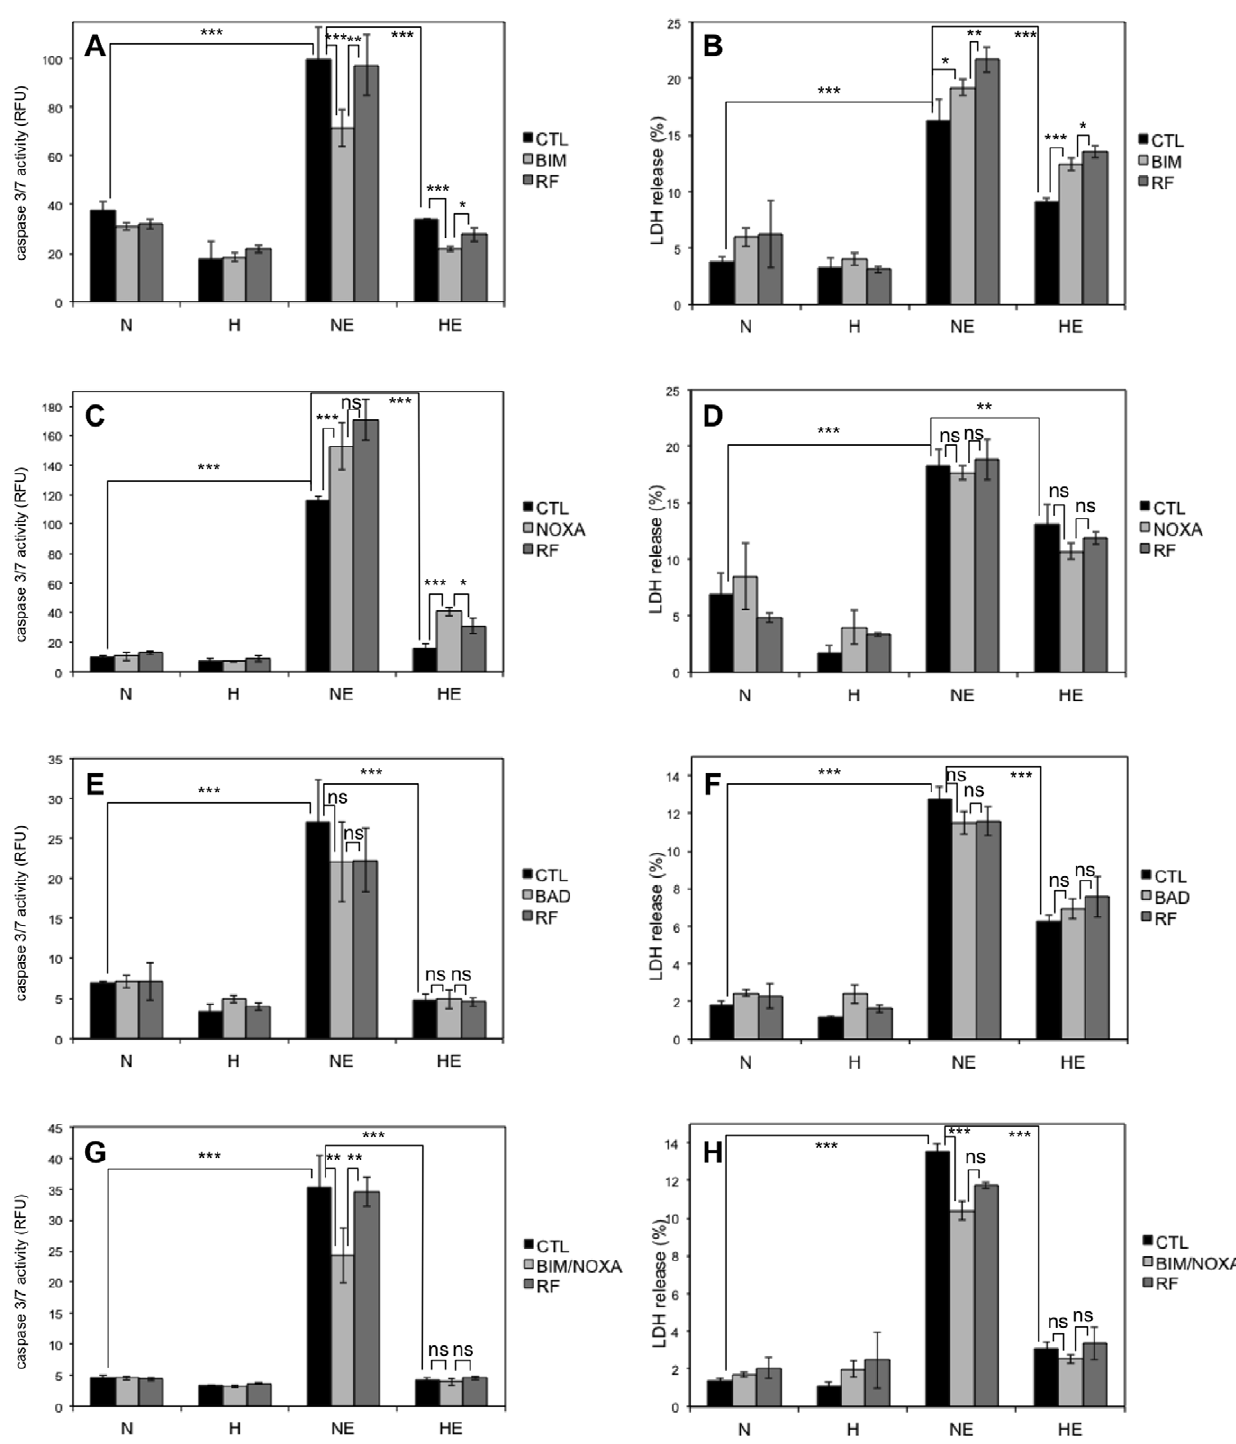
Figure 7. Effect of BH3-only proteins silencing on the etoposide-induced cell death . HepG2 cells were transfected with 50 nM BIM (A, B), NOXA (C, D) or BAD (E, F) siRNAs, or 25 nM BIM combined with 25 nM NOXA (G, H), or 50 nM RISC-free (RF) control siRNA or left untransfected (CTL) for 24 hours. 6 hours later (or 30 hours later for A and B), cells were incubated under normoxia (N, 21% O 2 ) or hypoxia (H, 1% O 2 ) with (ETO) or without (CTL) etoposide (50 m M) for 16 (A, C, E, G) or 40 hours (B, D, F, H). (A, C, E, G) Caspase-3/7 activity was assayed by measuring the fluorescence of free AFC released from the cleavage of the caspase-3/7 specific substrate Ac-DEVD-AFC. Results are expressed in relative fluorescence units (RFU) as means 6 1 SD (n =3). (B, D, F, H) LDH release was assessed. Results are presented in percentages as means 6 1 SD (n =4, but n =3 in B for the condition HE CTL and in f for the condition H BAD). (A-H) Statistical analysis was carried out with ANOVA 1. ns: non-significant; *: P , 0.05; **: P , 0.01; ***: P , 0.001.